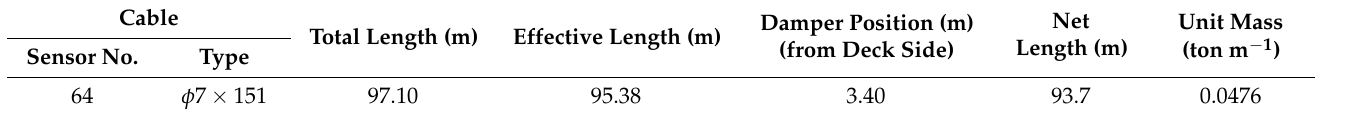
Figure 11. Sensor Figure 11. Sensor location.